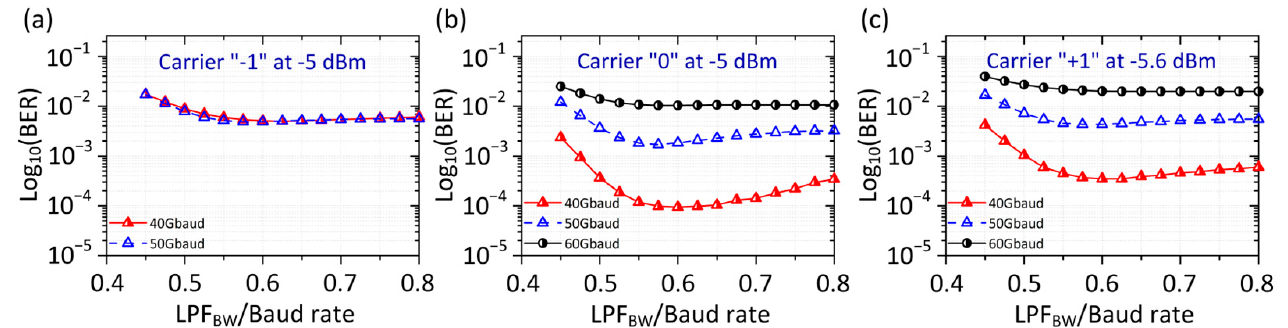
Figure 7. BER versus LPF bw /Baud rate for the IM/DD communication system operating on 400 GHz spaced carriers generated by microsphere Kerr-OFC: ( a ) λ = 1548.485 depicted as carrier “ − 1”; ( b ) λ = 1551.737 depicted as carrier “0”; ( c ) λ = 1554.992 depicted as carrier “+1” provide NRZ-OOK signals up to 60 Gbps/ λ .